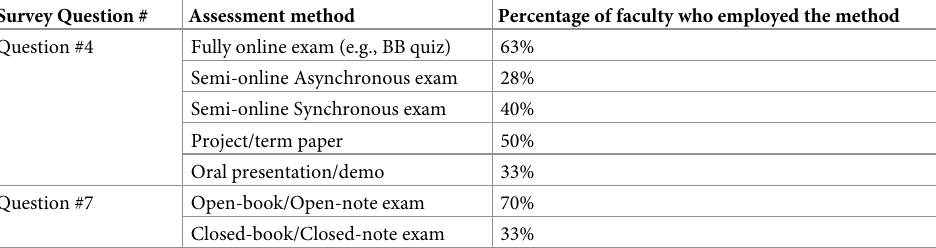
Table 1. Learning assessment methods faculty used during the online instruction in Spring 2020. The respondents could choose more than one option for each question depending on the number of exams administered during the